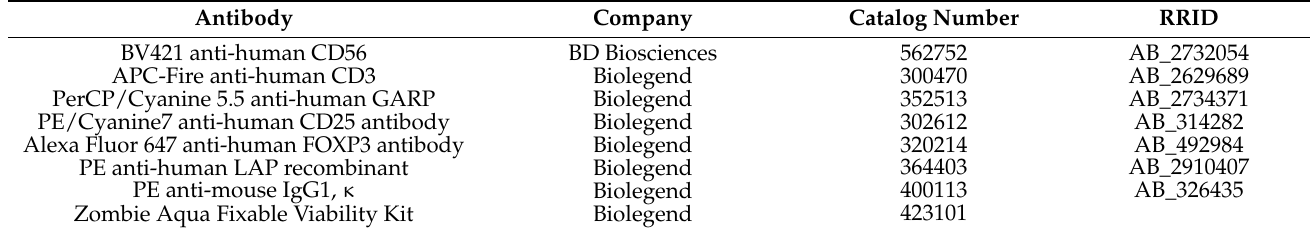
Table 2. Flow cytometry